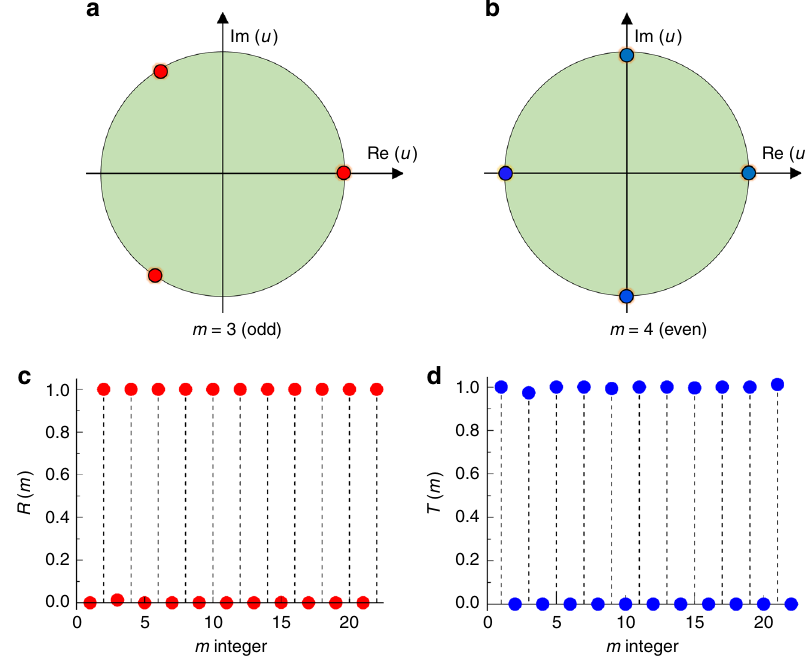
Fig. 5 Parity-dependent transmission and re fl ection and robust performance. a , b The phase distributions in the u -complex plane for m = 3 (odd) and m = 4 (even), respectively. c , d The re fl ection ( c ) and transmission ( d ) vs. integer m in a PGM with ξ = 1.5 k 0 based on coupled mode